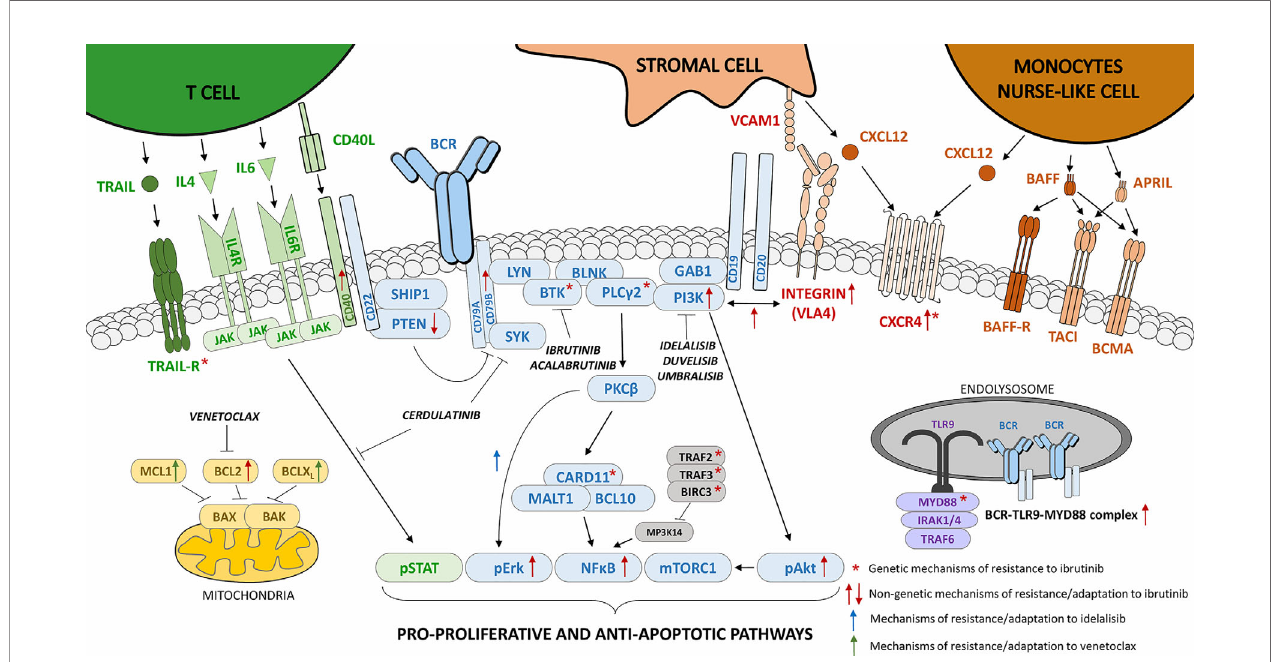
FIGURE 1 | The genetic and non-genetic mechanisms of resistance to BTK or PI3K inhibition in B cell malignancies. The “ * ” indicates genetic mechanisms of resistance to ibrutinib (BTK inhibitor), the red arrows indicate non-genetic mechanisms of resistance/adaptation to ibrutinib, the blue arrows indicate mechanisms of resistance/adaptation to idelalisib (PI3K inhibitor), and the green arrows indicate mechanisms of resistance/adaptation to venetoclax (BH3-mimetic [BCL2